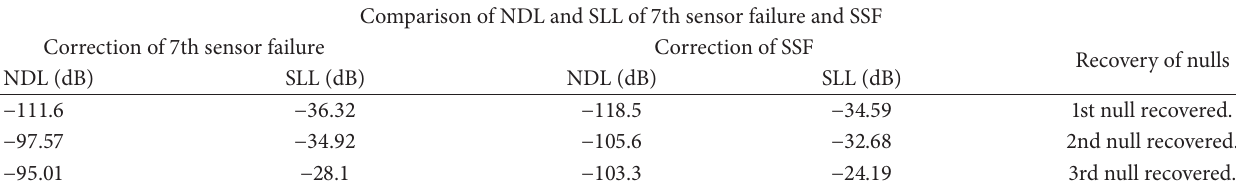
Table 5: Recovery of three nulls.